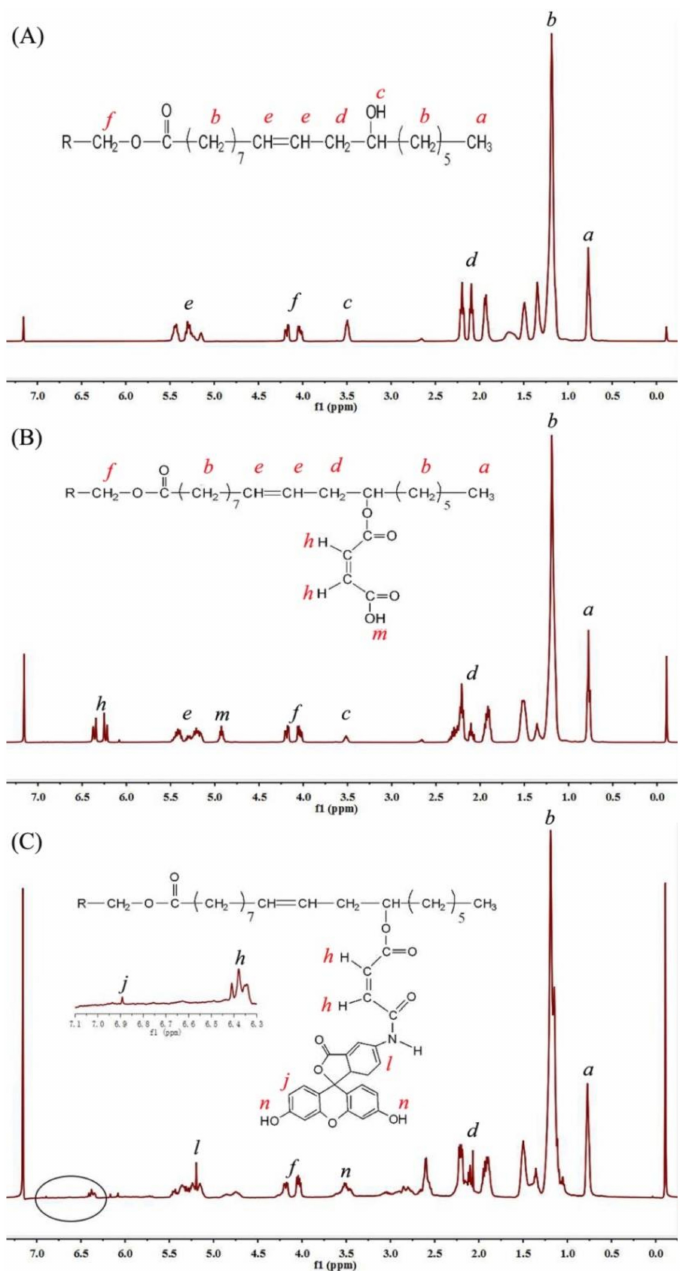
Figure 3. 1 H NMR of: ( A ) castor oil, ( B ) CCO and ( C )